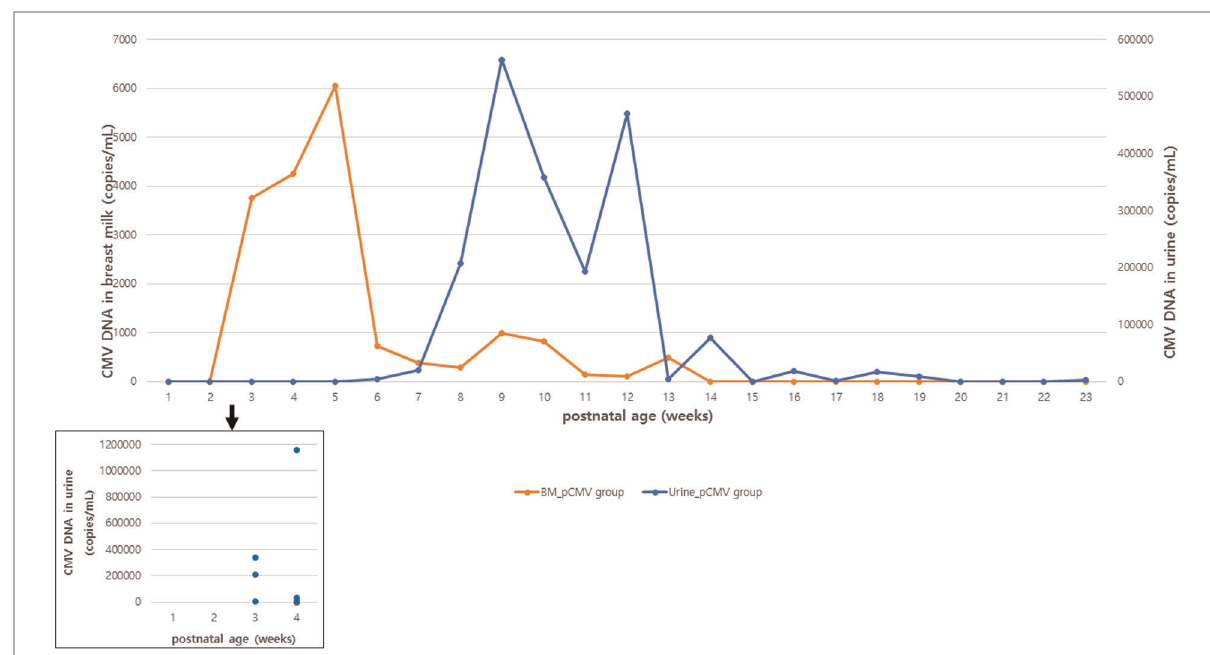
FIGURE 3 Median CMV load in breast milk and urine samples in infants with postnatal CMV infection. Orange and blue lines indicate the median copy numbers of CMV DNA in breast milk and urine. Blue dots indicate the copy numbers of CMV DNA in urine of infants with CMV PCR positive urine at 1 to 4 postnatal weeks. BM, breast milk; CMV,